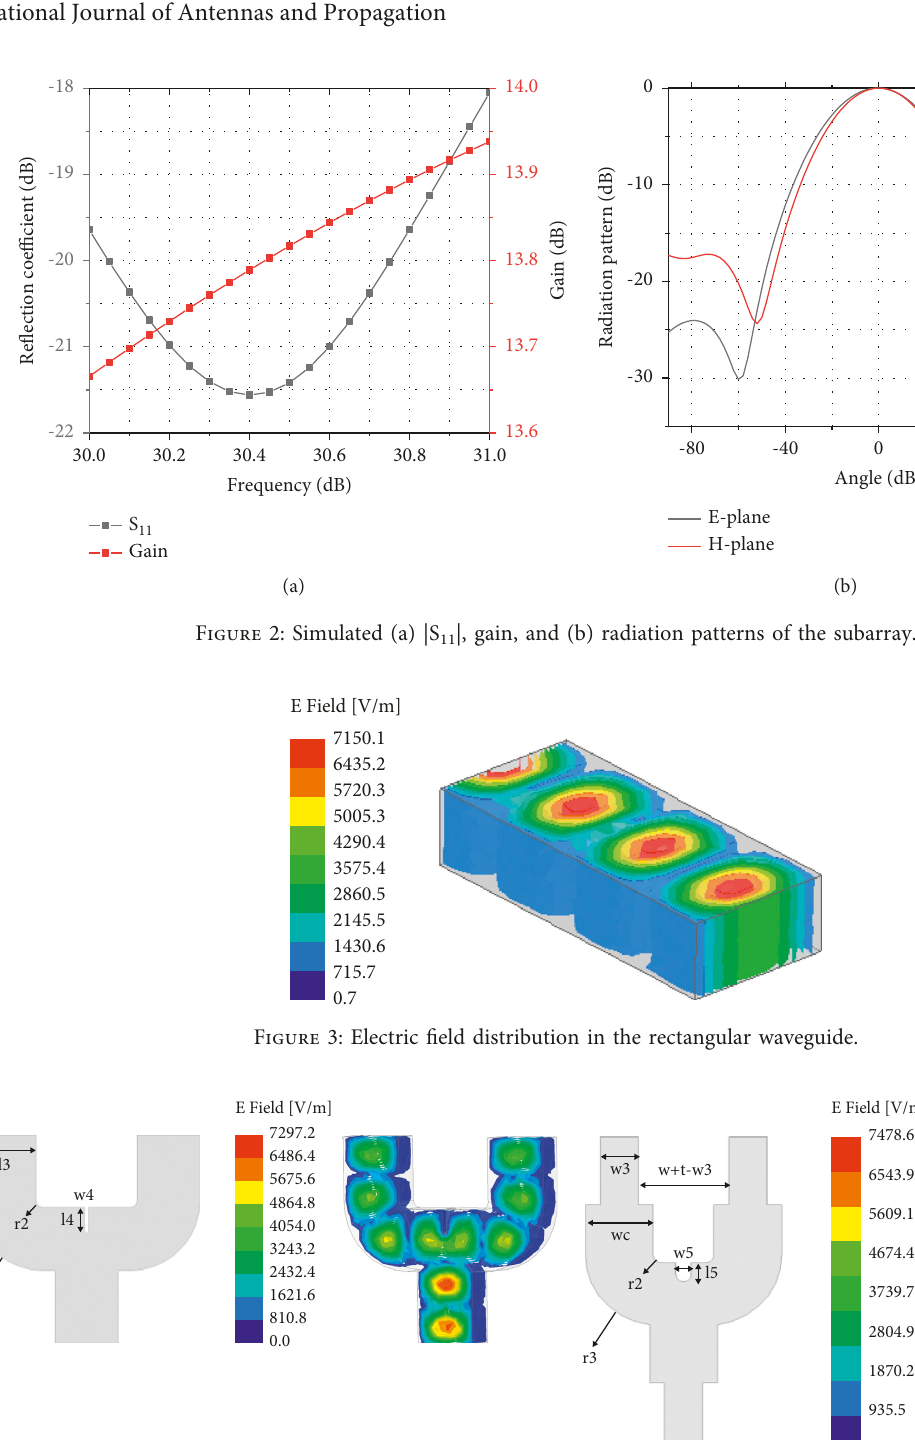
4.318mm, (cid:29) 9.84mm, and (cid:29)